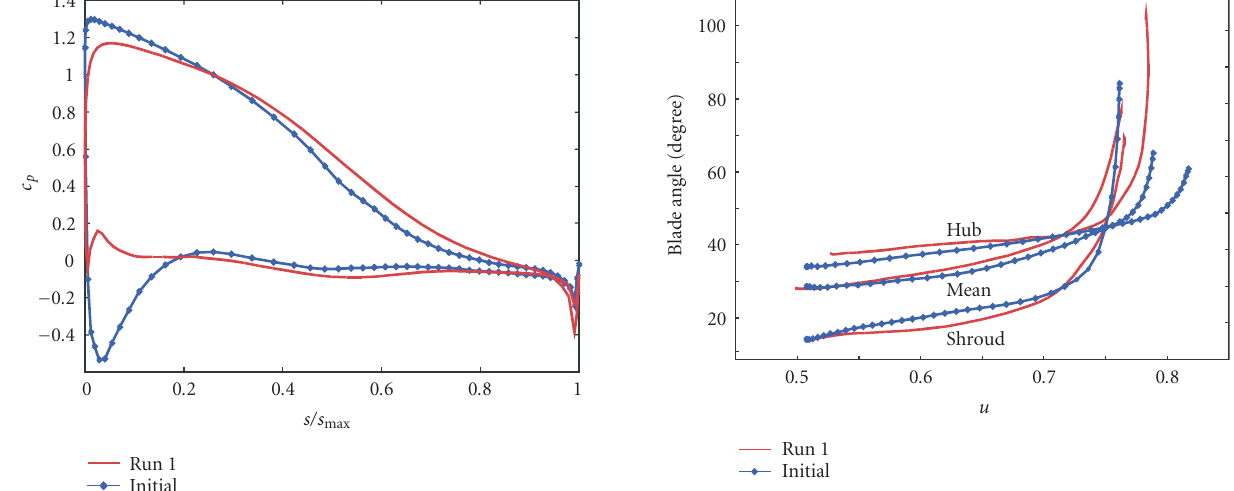
Figure 7: Pressure distribution at the shroud of the runner.